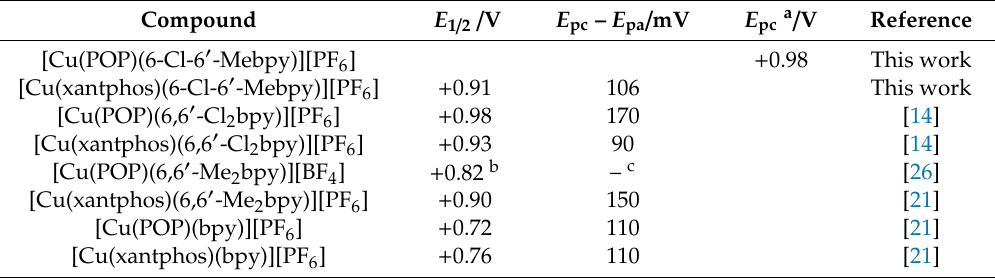
Table 2. Copper(I) / (II) oxidation potentials in [Cu(POP)(6-Cl-6 (cid:48) -Mebpy)][PF 6 ] and [Cu(xantphos)(6-Cl-6 (cid:48) -Mebpy)][PF 6 ] compared to those of related compounds. CH 2 Cl 2 solutions (ca. 10 − 4 mol dm − 3 ); values are referenced to internal Fc / Fc + = 0.0 V; [ n Bu 4 N][PF 6 ] as supporting electrolyte and scan rate of 0.1 V s − 1 .